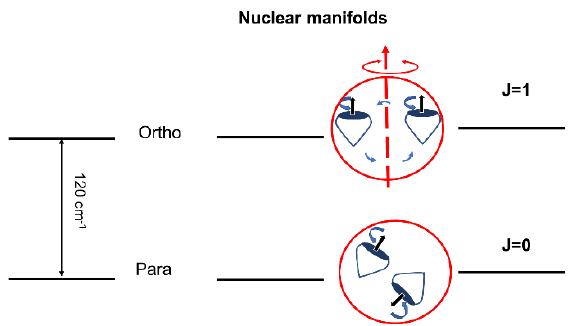
Fig. 3 . Nuclear ortho and para rotation and spin